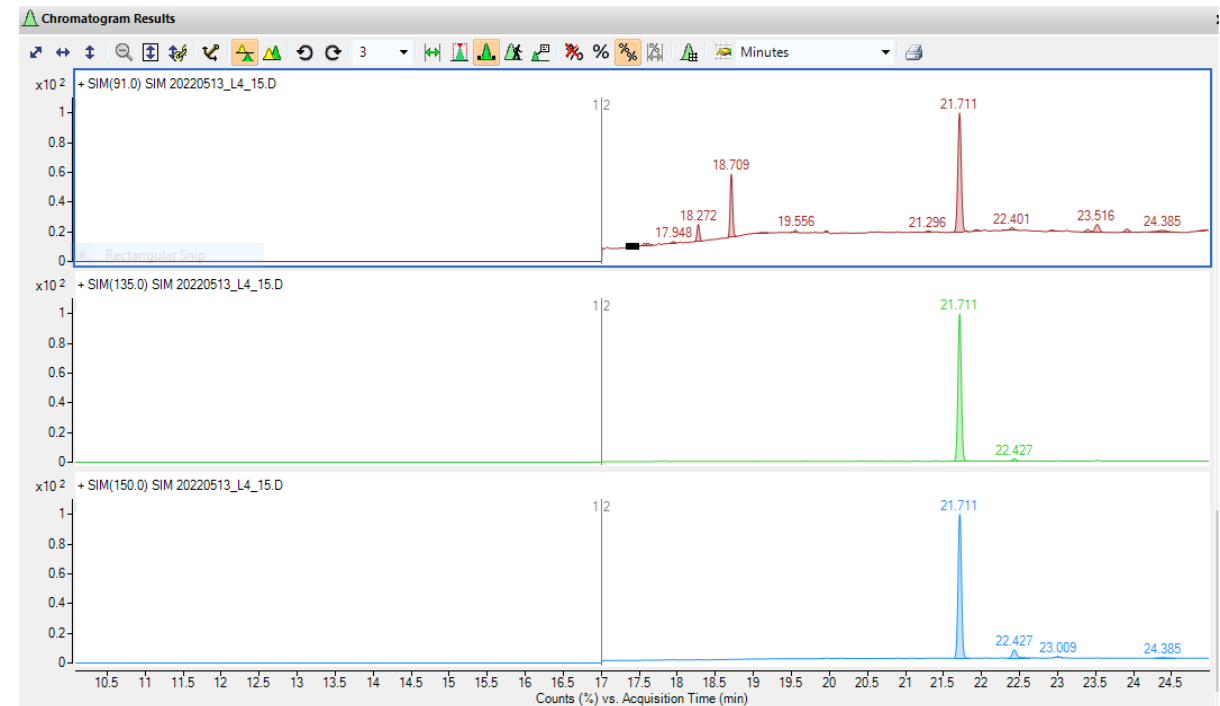
Figure A1. Chromatogram (SIM mode) of PDCB in beeswax. Quantitation ion m/z 146 and qualita- tive ions m/z 111 and 146.